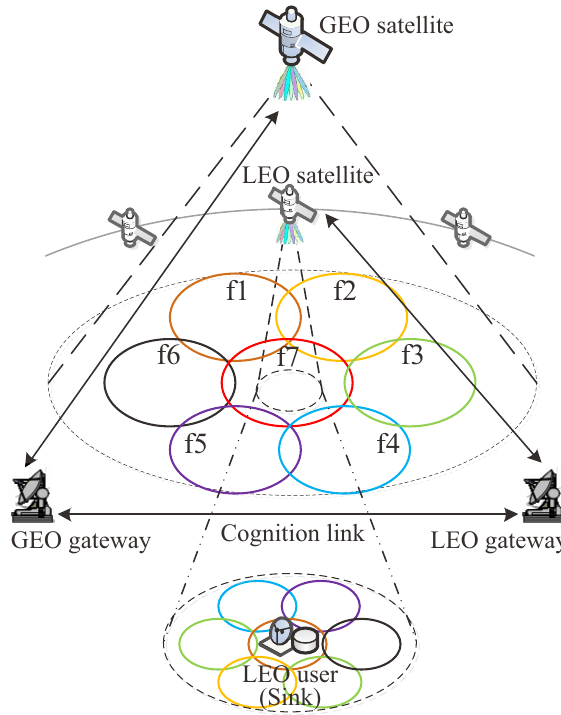
Figure 2. Schematic of the novel spectrum-sharing